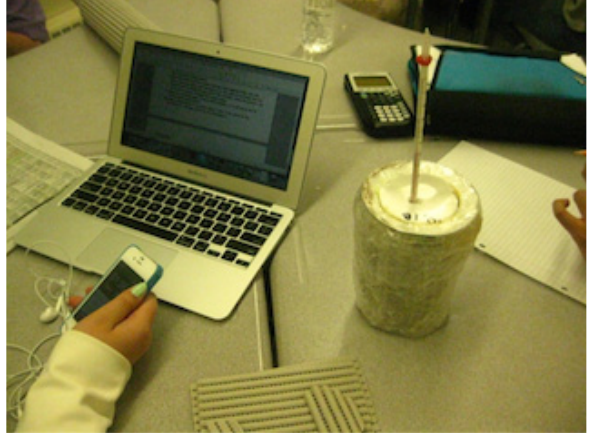
Figure 9. Example of test for efficiency in final thermos. more portable. One team also considered the use of more sustainable materials for the thermos for a lower ecologi- cal